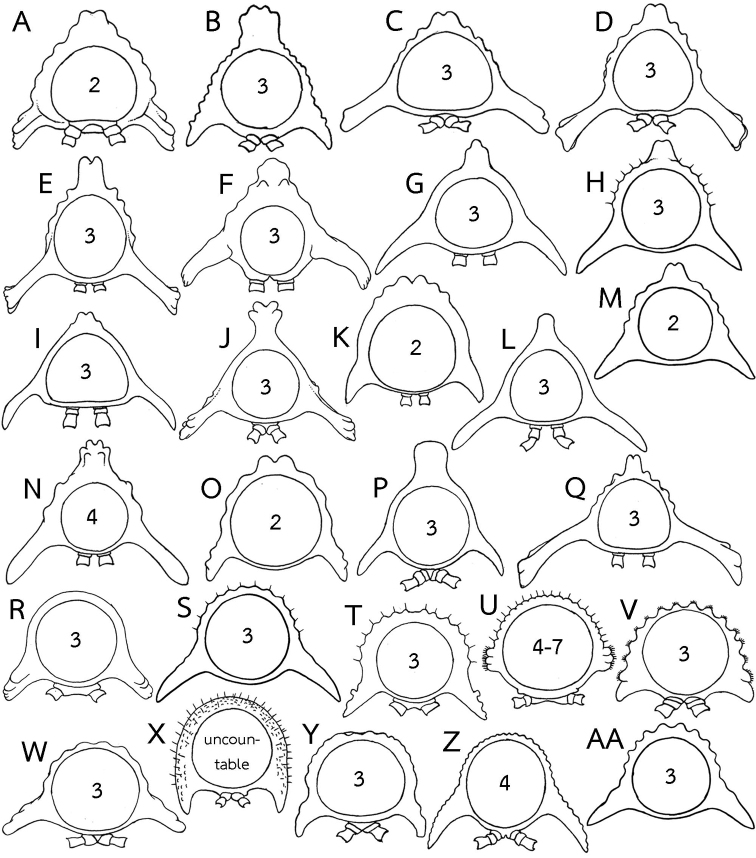
Body ring (posterior view) in several Eutrichodesmus species, number inside ring indicated rows of tubercles on metaterga. A–Q Species with mid-dorsal projections on metaterga. AE.
anisodentusBE.
asterCE.
asteroidesDE.
astriproximusEE.
astrisimilisFE.
cavernicolaGE.
deporatusHE.
dorsiangulatusIE.
lipsaeJE.
macclureiKE.
nodulosusLE.
parasterME.
pectinatidentisNE.
reclinatusOE.
soesilaePE.
steineri and QE.
subasteroidesR–AA Species without mid-dorsal projections on metaterga RE.
apicalisSE.
arcicollarisTE.
armatocaudatusUE.
armatusVE.
basalisWE.
cambodiensis sp. nov. XE.
communicansYE.
curticornisZE.
digitatus and AAE.
distinctus. Not to scale. Figures modified from A, M Zhang (1995) B, C, Y, AAGolovatch et al. (2009b)D, E, QGolovatch et al. (2016)FSinclair (1901)E, L, PLiu and Wesener (2017)H, S Zhang in Zhang and Wang (1993)I, RGolovatch et al. (2015)J, N Hoffman (1977) KVerhoeff (1939)OMakhan (2010)T, V, X, Golovatch et al. (2009a)UMiyosi (1951) and ZLiu and Tian (2013).